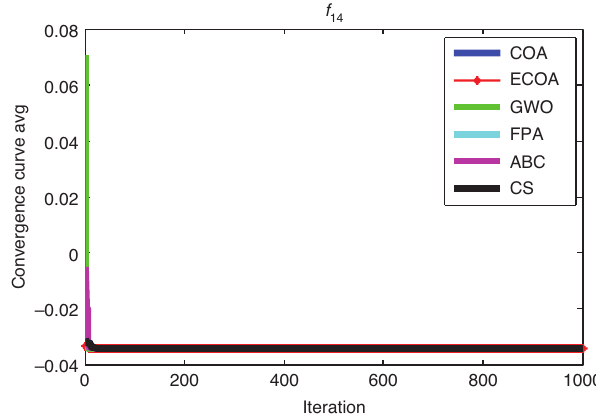
Figure 27: D = 2, Evolution Curves of Fitness Value for f